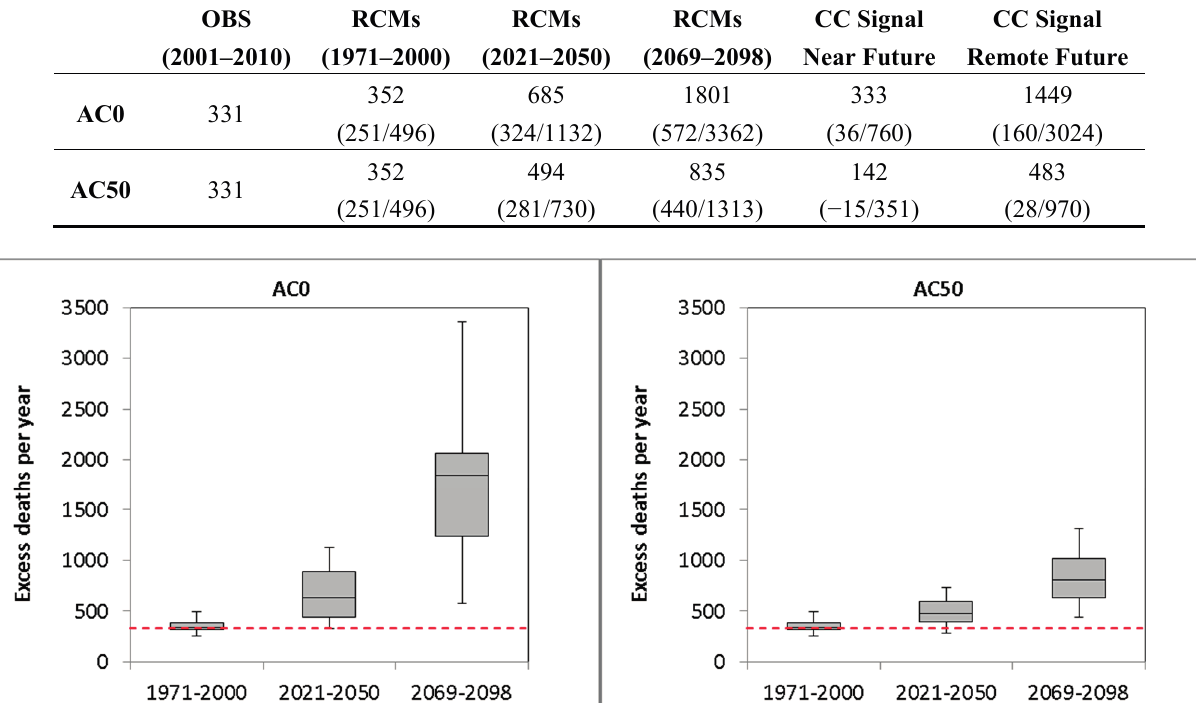
Figure 5. Projected IHD excess deaths per year in Germany attributable to heat waves from 19 regional model simulations for 1971–2000, 2021–2050, and 2069–2098 according to two acclimatization approaches: AC0 ( left ) and AC50 ( right ). The red dotted line denotes the annual number of IHD excess deaths assessed from observations (OBS) based on mortality and weather station data for the period 2001–2010. The box plots depict the distribution of the RCM simulation results: the bottom and top of the boxes denote the first and the third quartile, the band inside the box is the median, and the ends of the whiskers represent the minimum and maximum of the ensemble